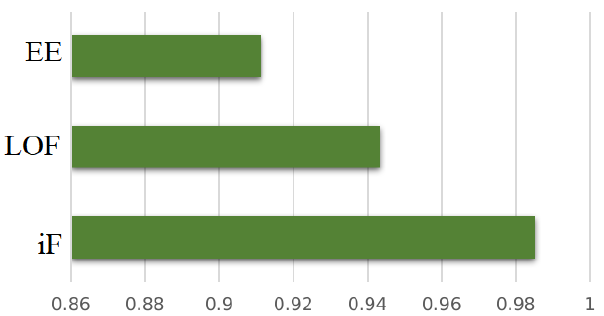
Figure 9. Averaged AUC obtained per anomaly detector for all EEG signal